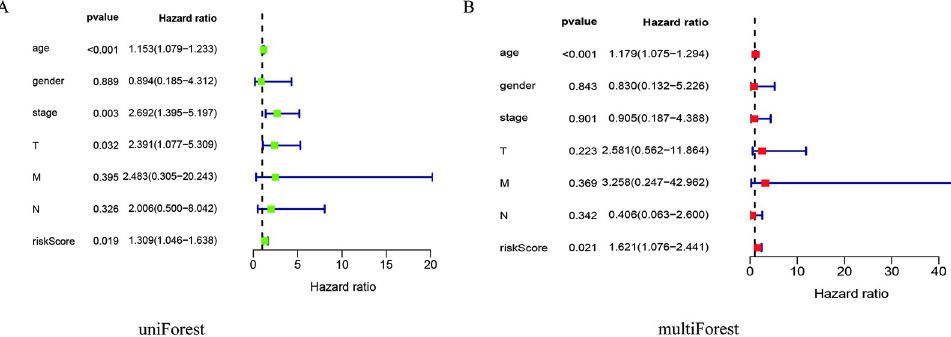
Fig 6. Univariate and multivariate Cox analysis. (A) Univariate Cox analysis; (B) multivariate Cox analysis.